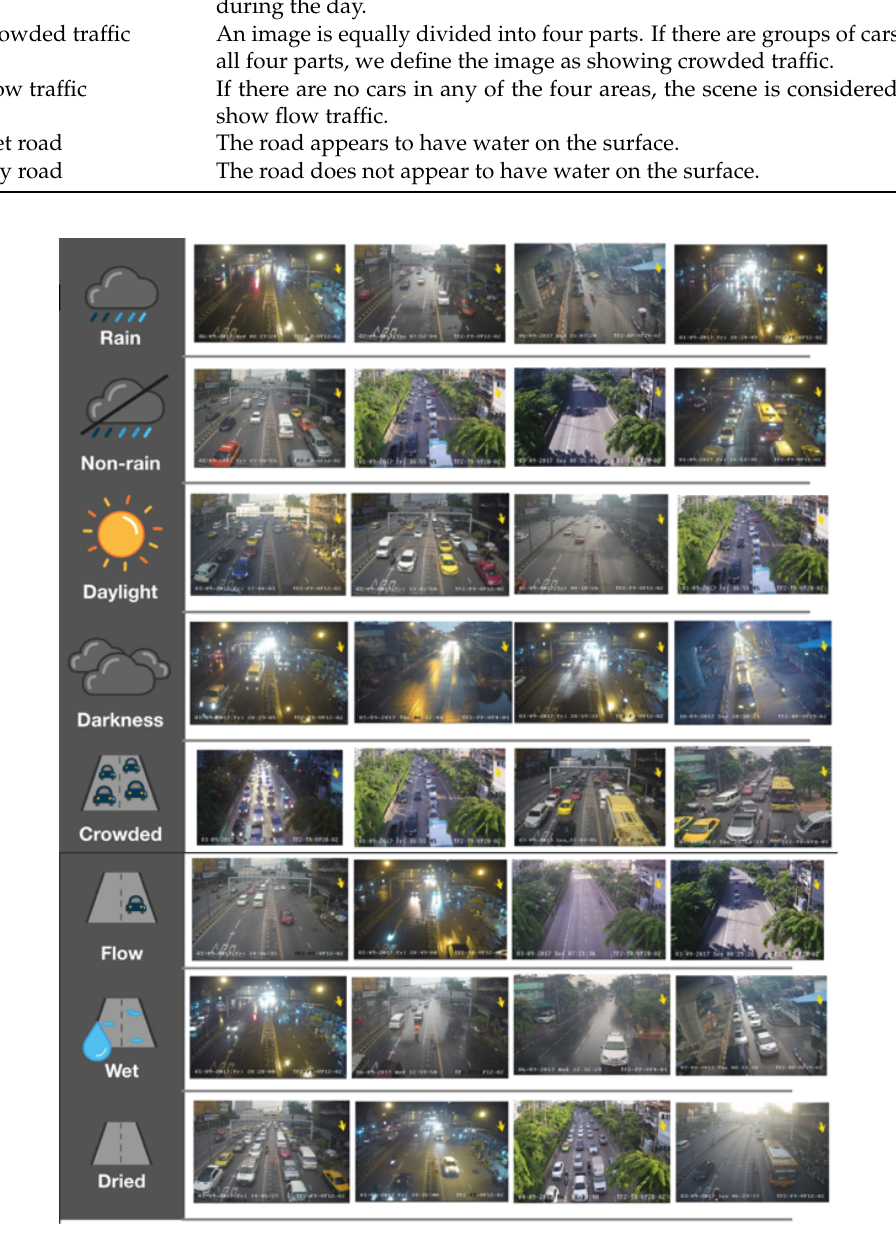
Figure 2. Examples of images for each